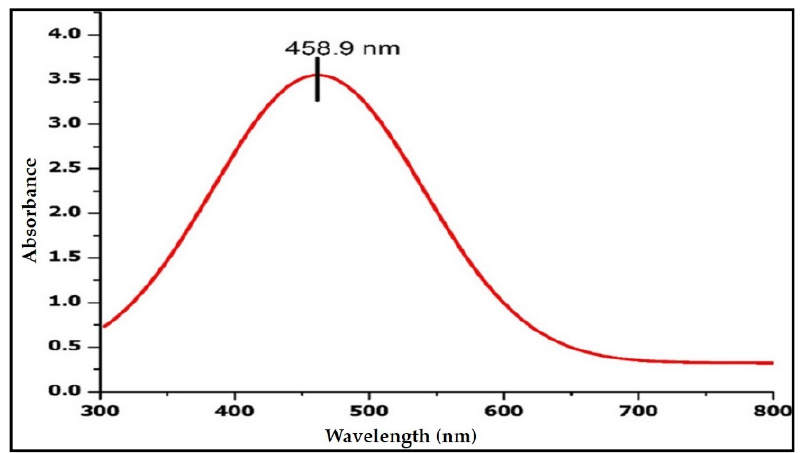
Figure 2. Silver nanoparticles were confirmed by UV-VIS spectral spectroscopy of colloidal solution.